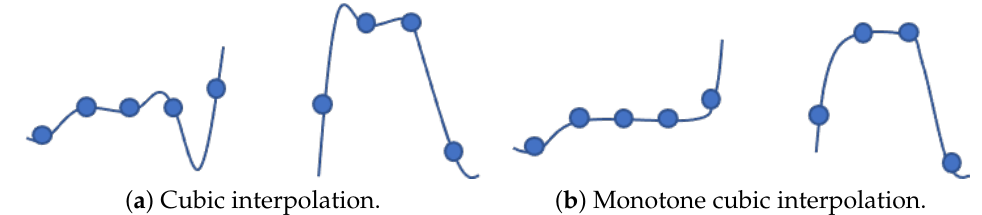
Figure 17. Link points